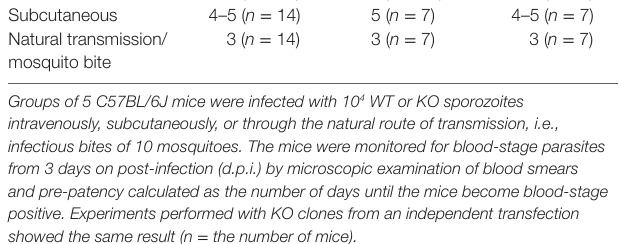
TaBle 1 | Mice infected through various routes with PbmaLS_05 ( − ) sporozoites show the same pre-patency as those infected with Pb ANKA WT. route of infection